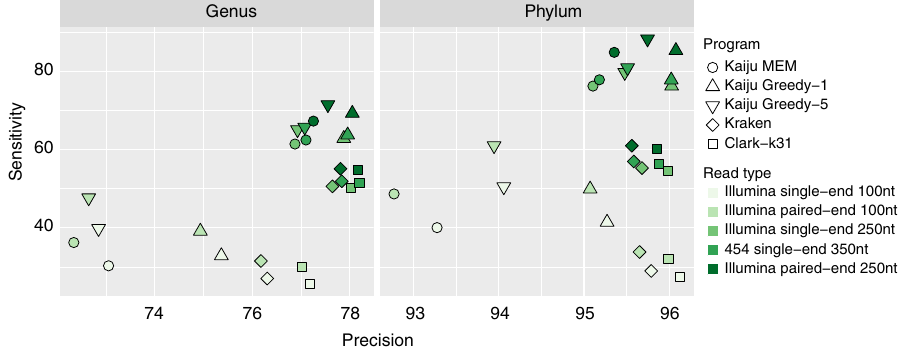
Figure 2 | Average sensitivity and precision. For each of the five types of reads, sensitivity and precision were averaged over all 882 measured genomes in the benchmark, showing the overall performance of each program.